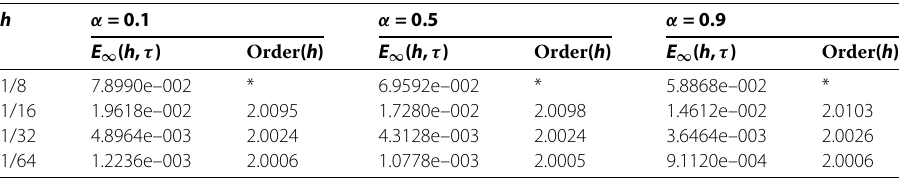
Table 4 The numerical convergence orders in spatial direction with τ